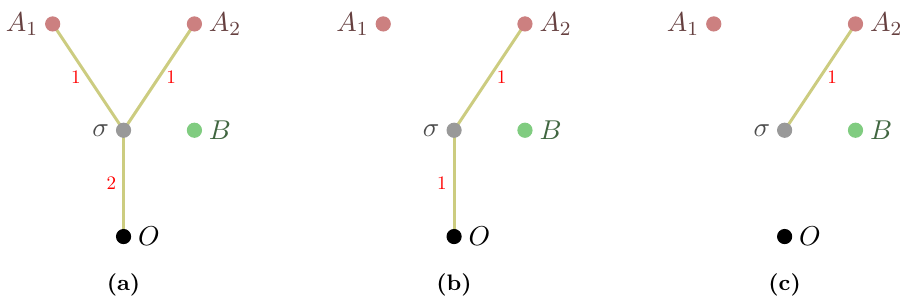
Figure 10. Graph models specified by particular choices of weights discussed in the main